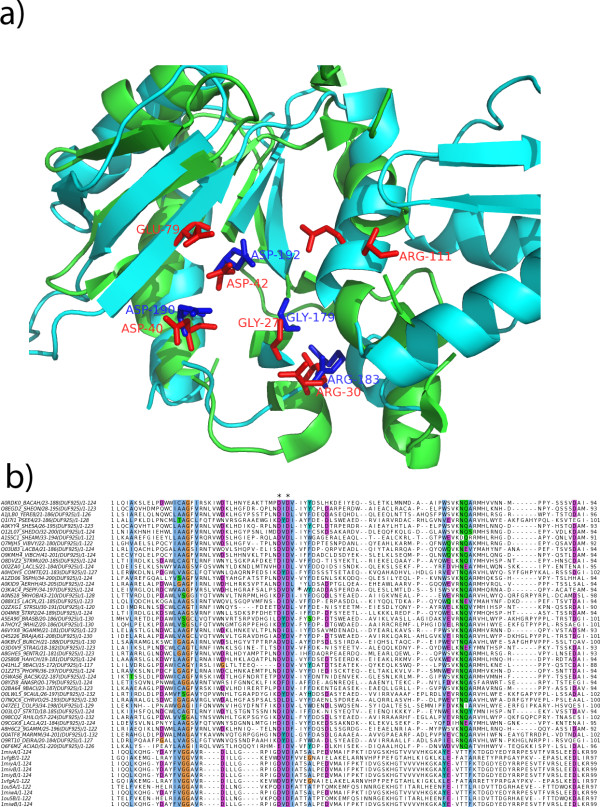
Assessment of function annotation transfer between the DUF925 family and the Nucleotidyl transferase family (d.218.1.4). a) The structural alignment between two proteins in the SCOP superfamily of Nucleotidyltransferase, 1miv (shown in blue) and 7icq (shown in green). The active site residues in 1miv are shown in red, and the active site residues of 7icq are shown in blue, both in the stick format. The nucleotide binding residues in 1miv (Asp40 and Asp42) are seen to be aligned with the nucleotide binding residues of 7icq (Asp190 and Asp192). The active site is mostly conserved, but there are some differences between the two proteins which could perhaps explain the different substrates and mechanism employed by the two proteins. b) The alignment between the DUF925 family proteins and the SCOP family d.218.1.4 proteins. The alignment shows that the Aspartate residues important for binding nucleotides are conserved across the two families, but the conservation of other active site residues is not observed. Alignment figure generated using Jalview [39] and structure figure generated using PyMOL [40].